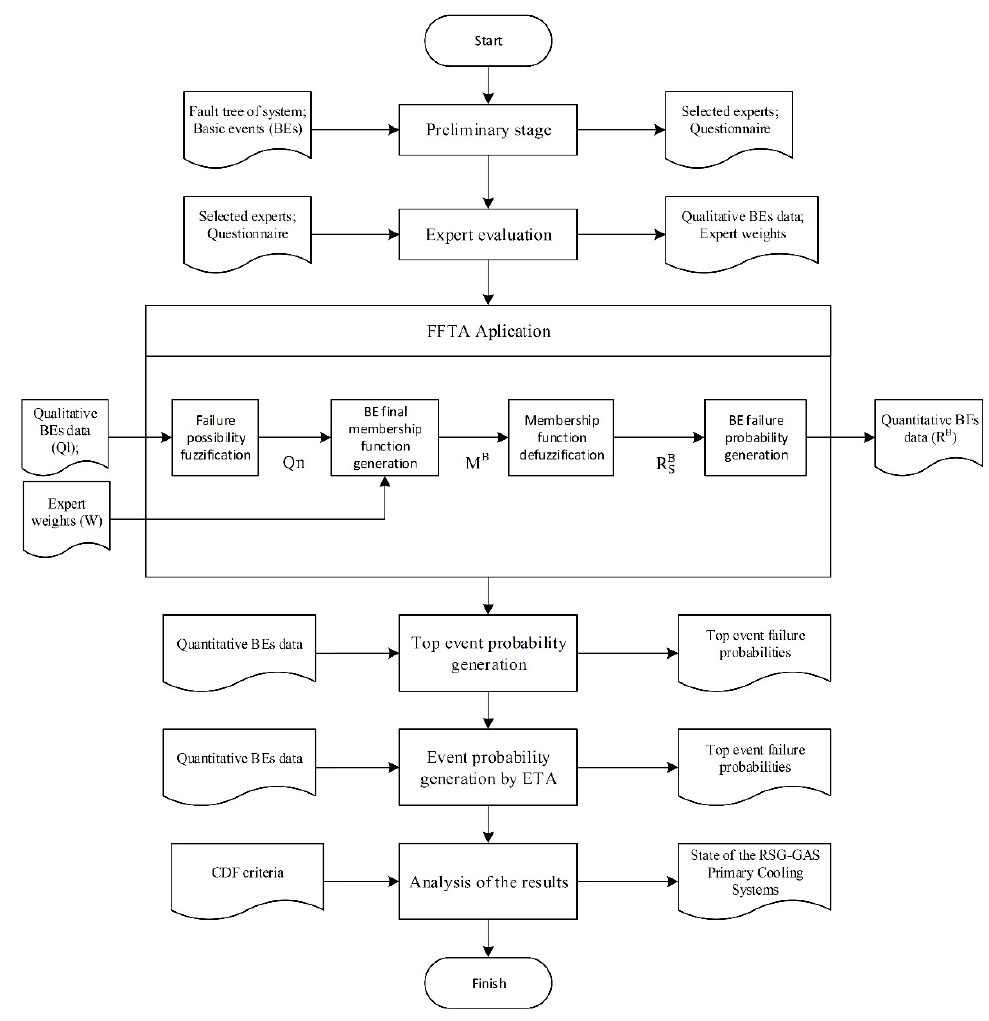
Figure 2. Research Figure 2. Research procedure.